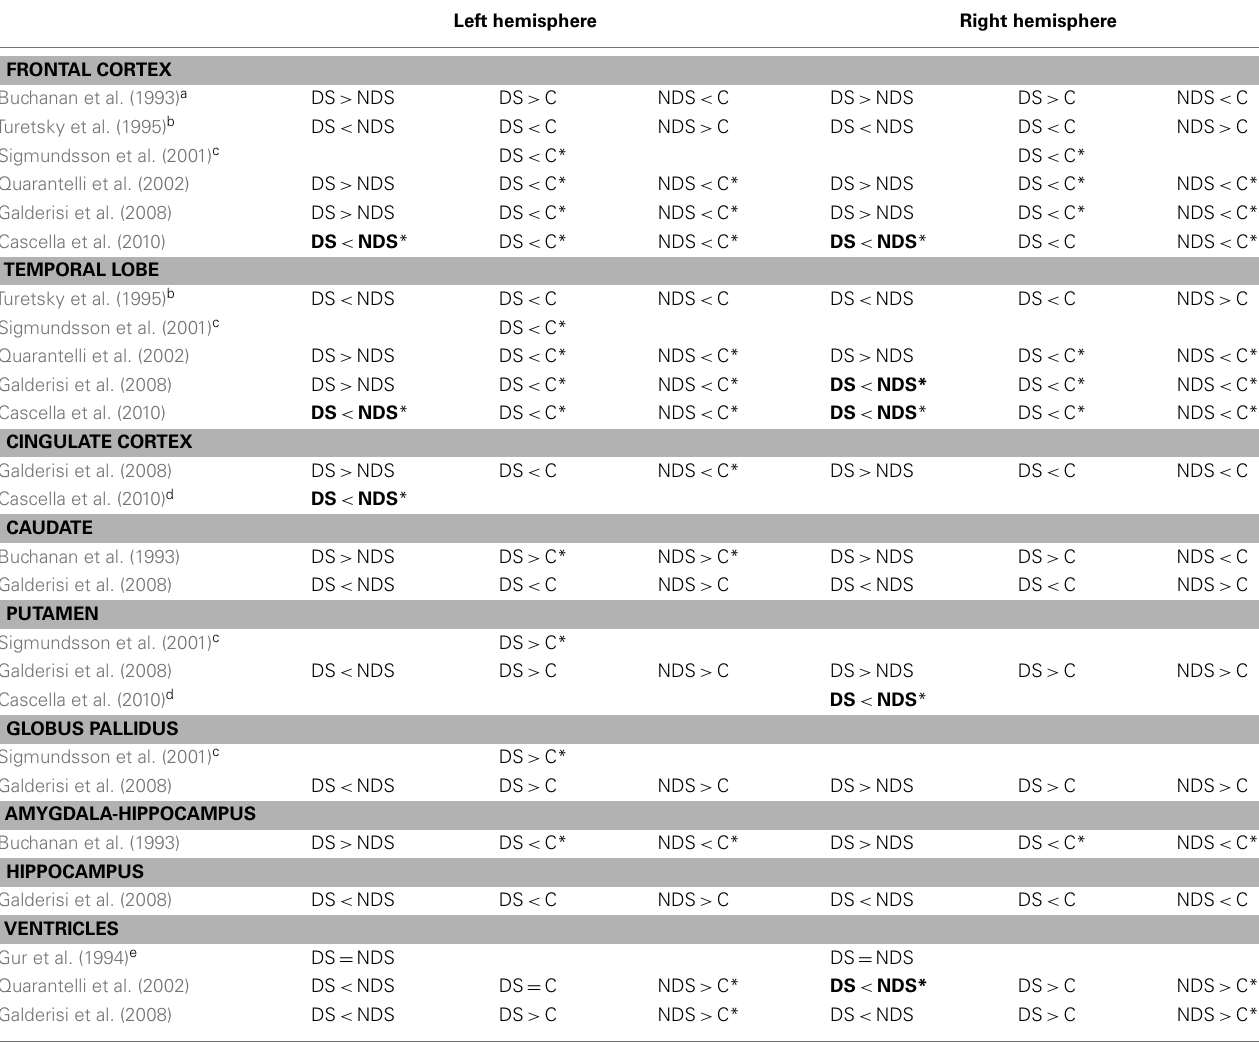
Table 1 | Summary of neuroimaging results examining deficit syndrome schizophrenia.